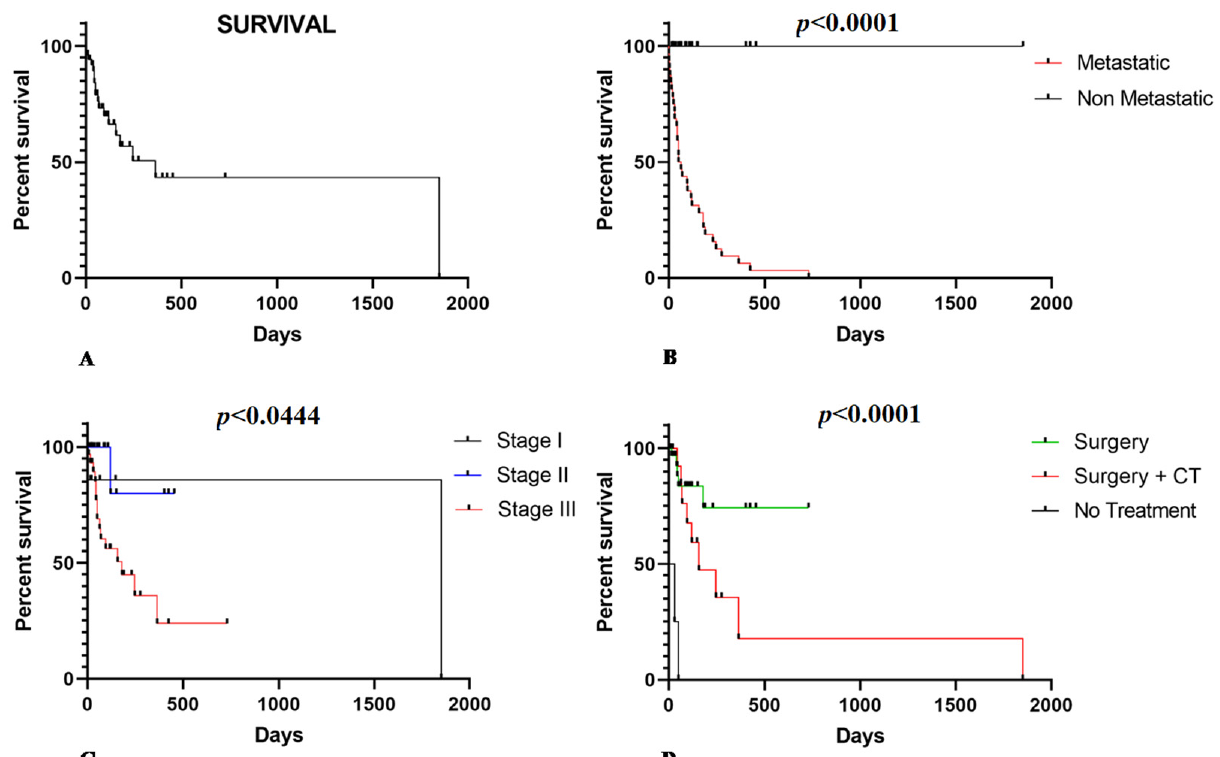
Figure 1. ( A ) Overall survival in HSA-affected dogs according to clinical pathological criteria. ( B ) Patients with metastatic splenic HSA experienced a shorter survival time ( p < 0.0001). ( C ) Patients at stage III show shorter survival time than stage I and II patients ( p = 0.0444). ( D ) Patients that received surgical or surgery associated with adjuvant chemotherapy (CT) as treatment show a longer survival time than those that did not receive treatment or only surgery treatment ( p <